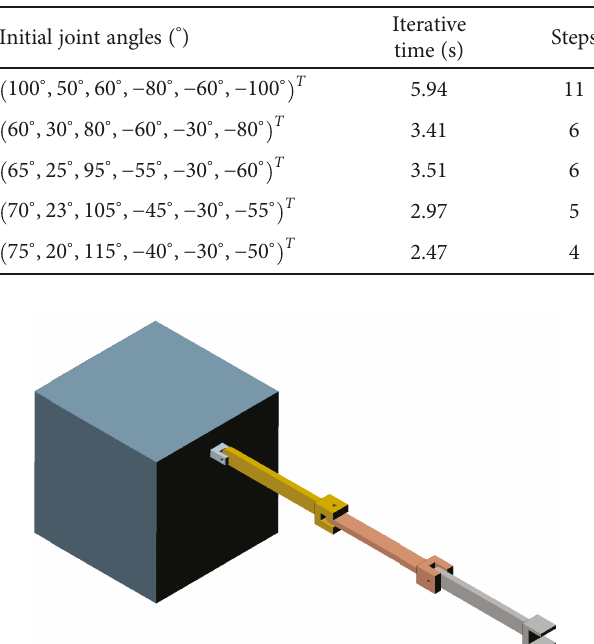
Table 2: Simulation results of iterative time and number of iterative steps.